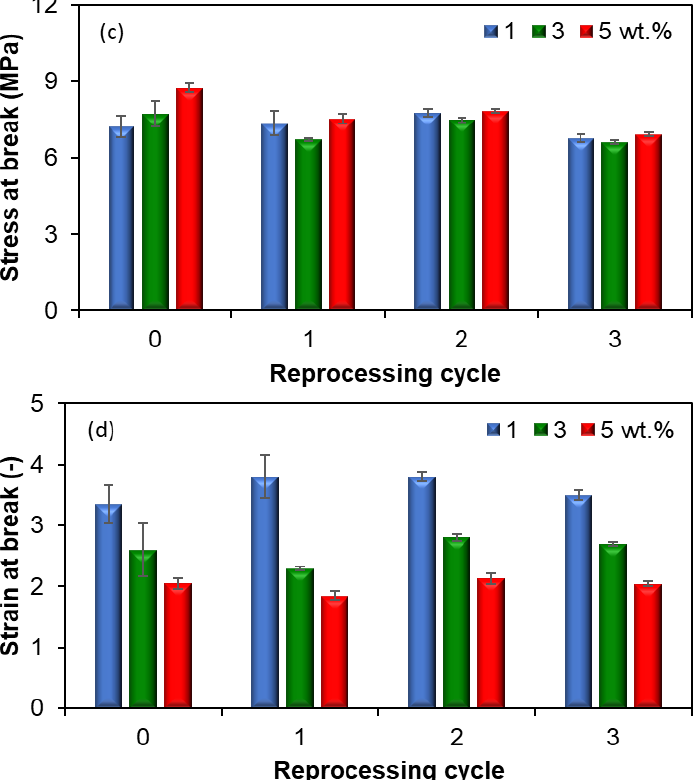
Figure 13. Effect of reprocessing cycle on the ( a ) Young’s modulus, ( b ) tensile strength, ( c ) stress at break and ( d ) strain at break for the EVA/MWCNT nanocomposites.